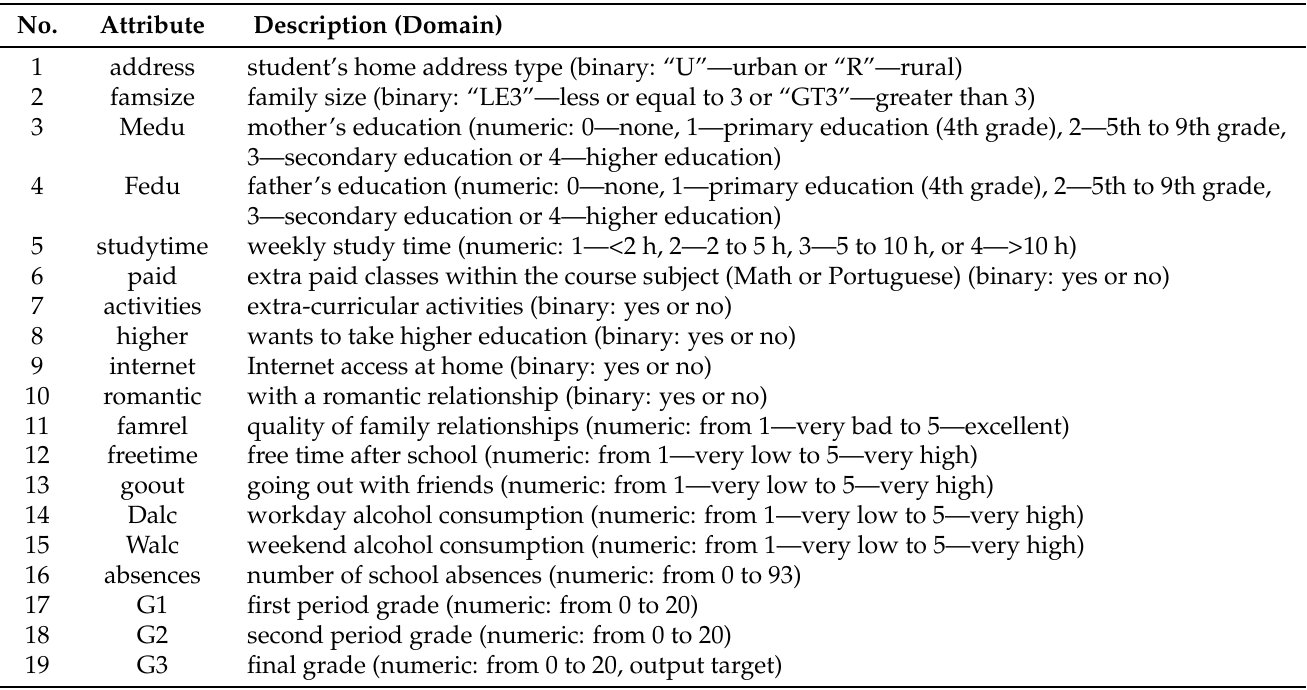
Table 1. Preprocessed student-related variables and their